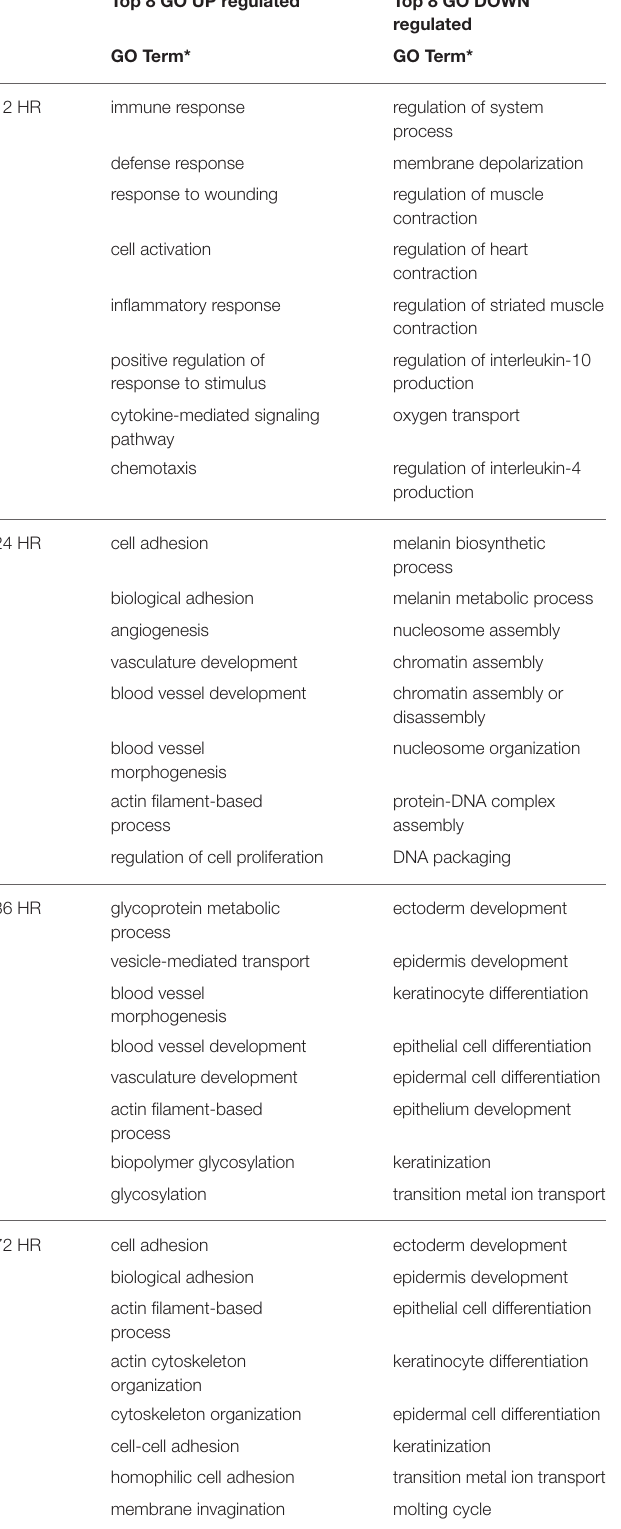
TABLE 1 | Top Gene Ontologies changed at each time point. Top 8 GO UP